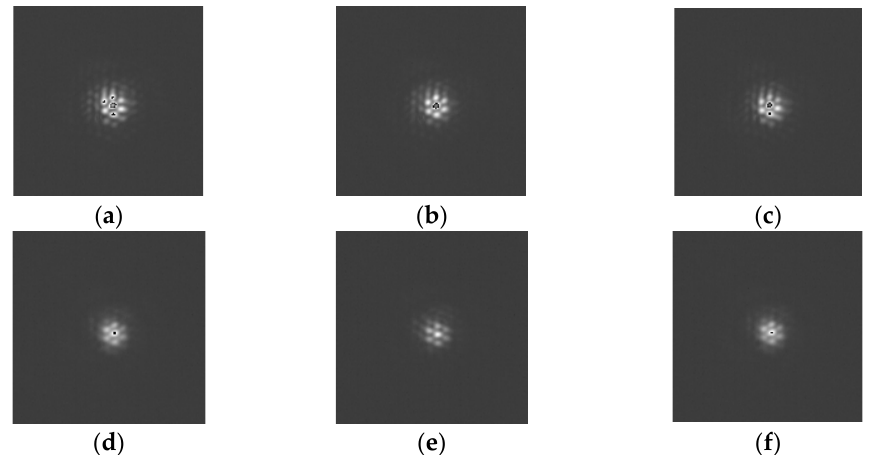
Figure 9. Images obtained from the focal plane detector feedback during the tracking of trajectory-1.